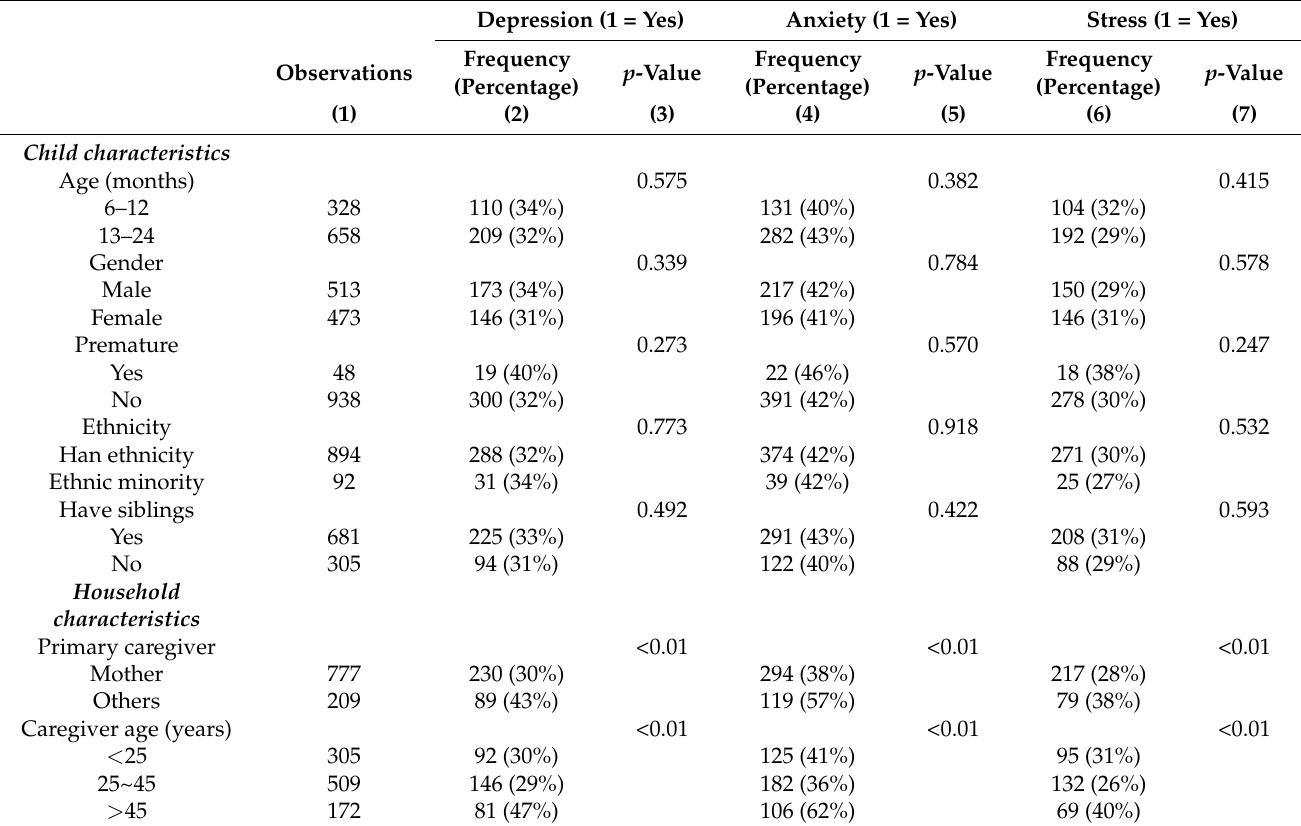
Table 3. Distribution of caregiver’s mental health severity by demographic characteristics, n =